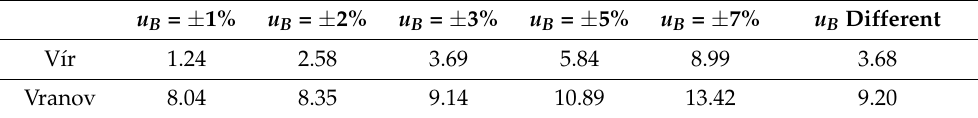
Table 4. Percentage increases (%) of the resulting variances ± 2 σ ( V Z ) of the optimized reservoir volume depending on the input uncertainties u B for the tested reservoir and another reservoir.